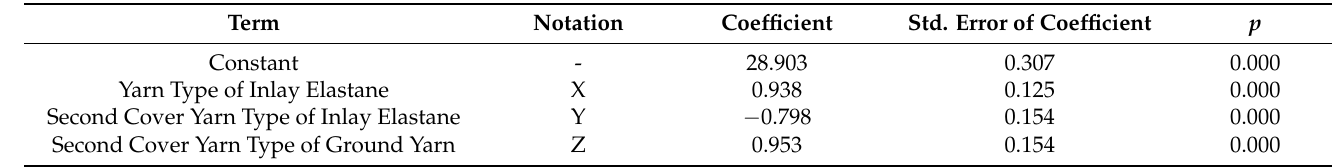
Table 3. Estimated effects of the variables on circumference changes.